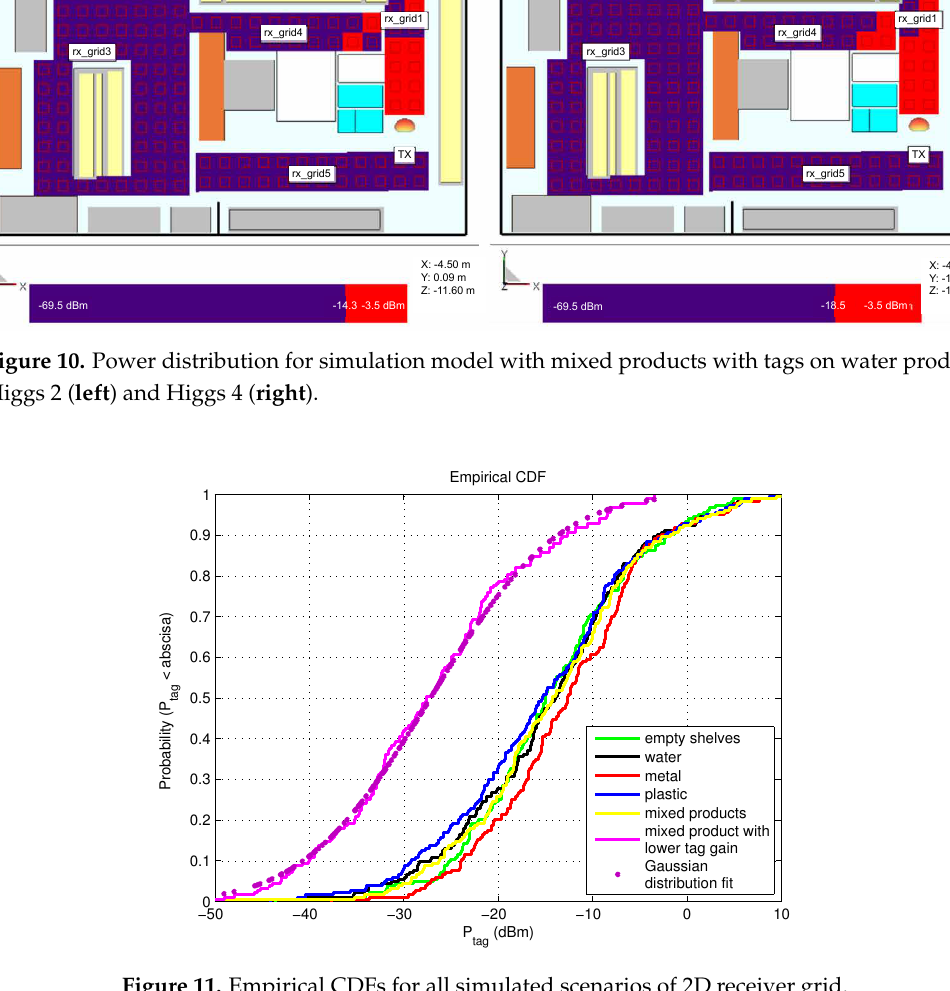
Figure 11. Empirical CDFs for all simulated scenarios of 2D receiver